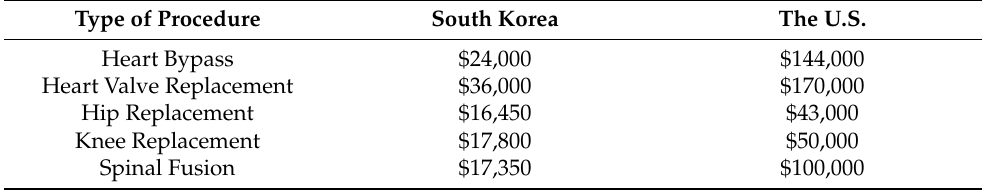
Table 3. The difference in medical costs between South Korea and the US. Type of Procedure South Korea The U.S. Heart Bypass $24,000 $144,000 Heart Valve Replacement $36,000 $170,000 Hip Replacement $16,450